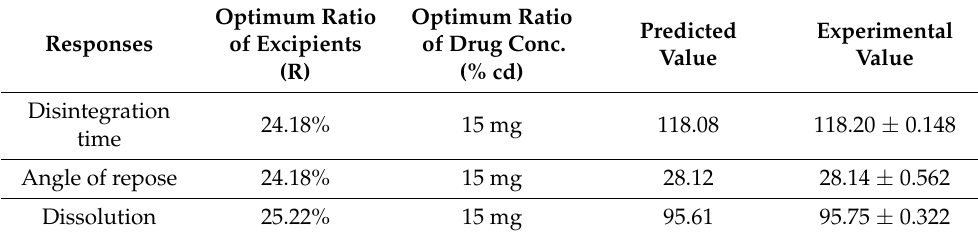
Table 6. Predicted and experimental values for three